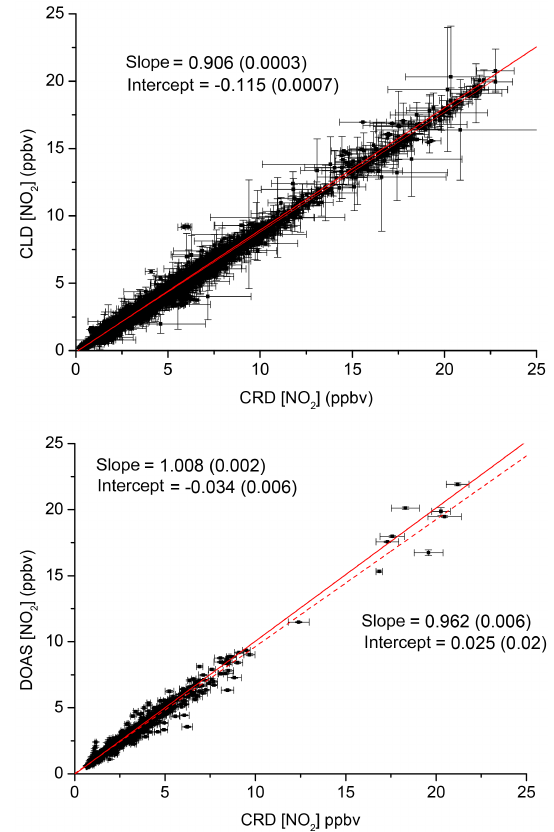
Figure 16. Comparison of NO 2 data (reference cavity) from the TD-CRDS with two established instruments. Upper panel: chemi- luminescence detector (CLD), 1min data averages. Lower panel: long-path differential absorption spectrometer (DOAS), 10min data averages. The red solid lines are weighted bivariant fits considering reported standard deviations for both instruments; the dashed line is an unweighted fit. For the DOAS comparison, only data were used for which the CRDS indicated standard deviations of less than 5% (over 10min